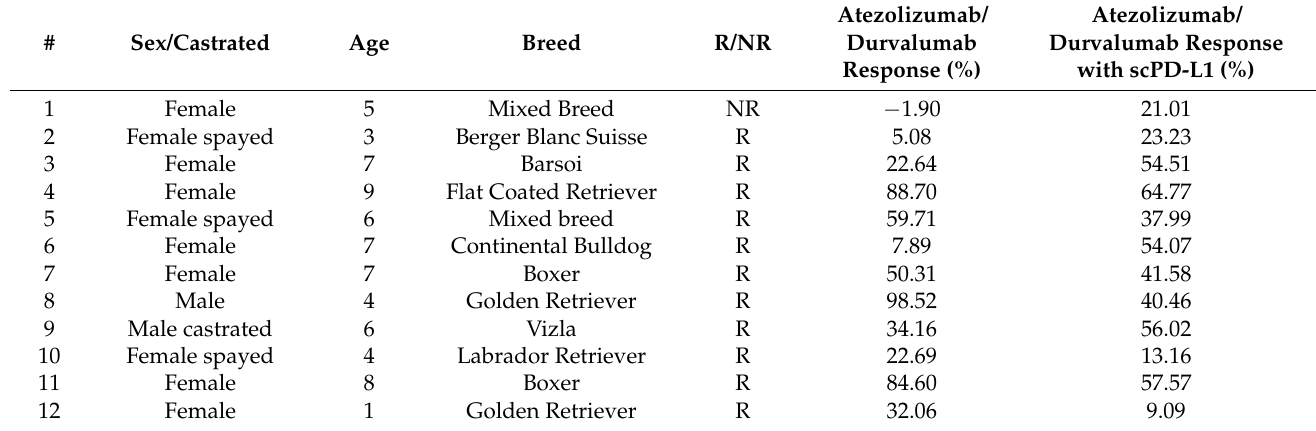
Table 2. Characteristics of healthy donors used in the study. Responders (R), non-responders (NR) to